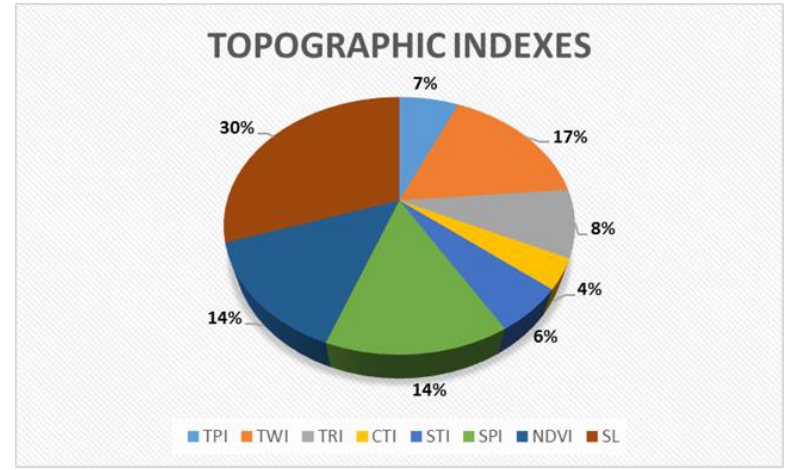
Figure 1. Pie chart illustrating the most and least frequently calculated landslide indexes.